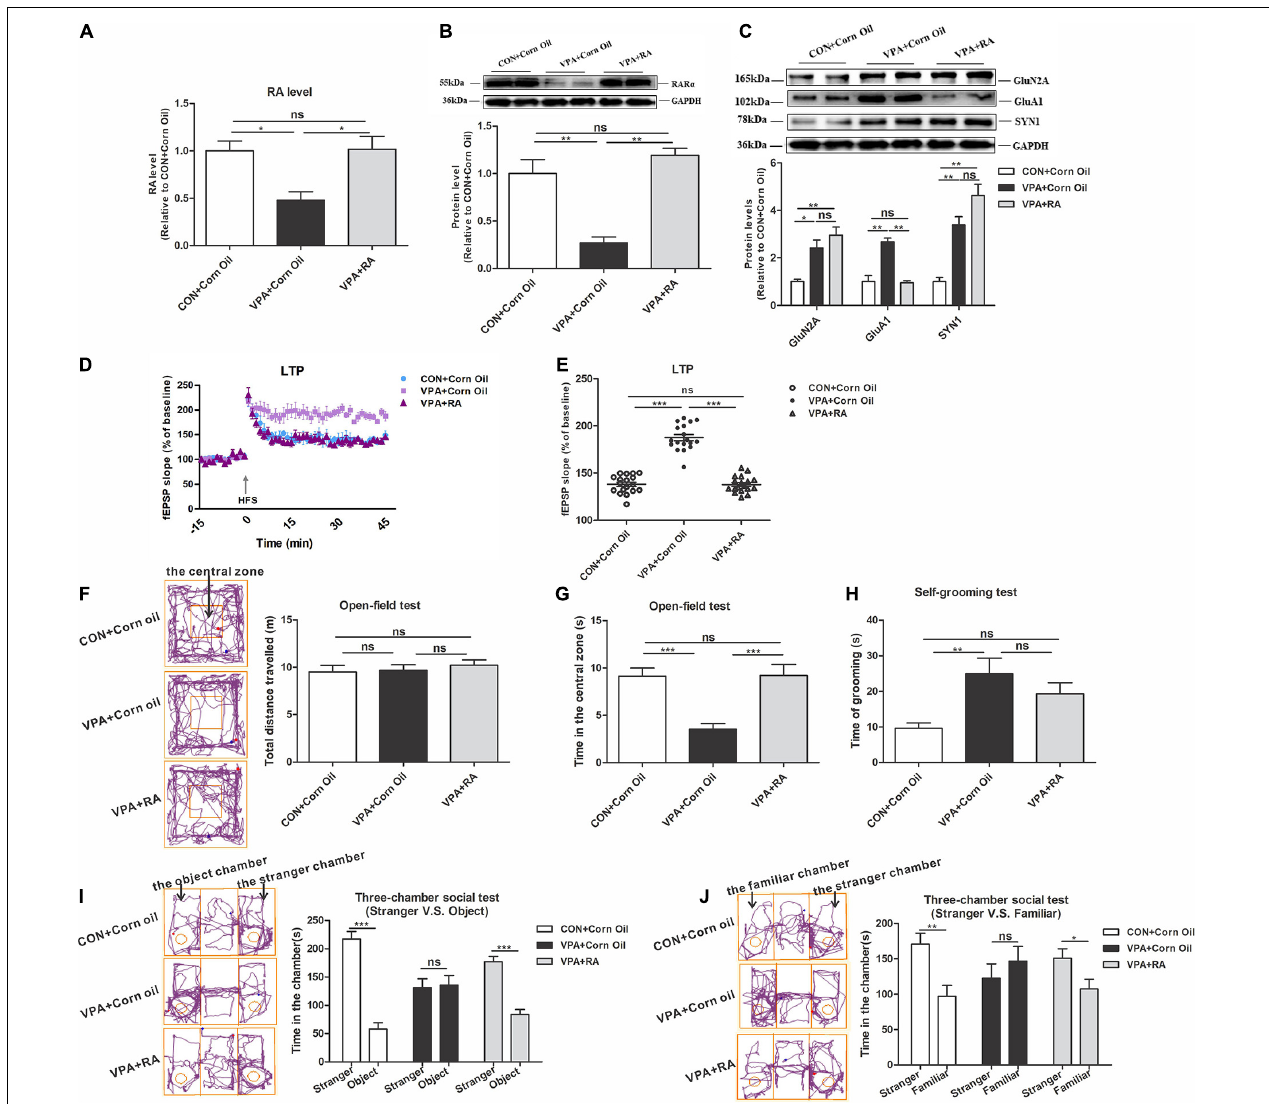
FIGURE 7 | Changes in RAR α expression levels, homeostatic synaptic plasticity and autism-like behaviors in VPA-exposed offspring following RA intervention. (A) RA levels in the PFC from the CON + Corn Oil, VPA + Corn Oil, and VPA + RA groups, as quantitated using UPLC-MS/MS ( n = 5 per group). (B) Western blot and quantification analyses of RAR α protein in the PFC from the CON + Corn Oil, VPA + Corn Oil, and VPA + RA groups ( n = 3 per group). (C) Western blot and quantification analyses of GluN2A, GluA1, and SYN1 protein in the PFC of offspring from the CON + Corn Oil, VPA + Corn Oil, and VPA + RA groups ( n = 3 per group). (D) Summary graphs of PFC LTP in the CON + Corn Oil, VPA + Corn Oil, and VPA + RA groups ( n = 9 slices from four rats per group). (E) LTP magnitude was measured as an average potentiation at 41–45 min after the onset of HFS induction ( n = 9 slices from four rats per group). (F–J) Behavioral tests were performed in offspring from the CON + Corn Oil, VPA + Corn Oil, and VPA + RA groups beginning at PND 43. (F) The tracing and total distance traveled in the open-field test ( n = 20–22 per group, F 2 , 57 = 0.356, P = 0.702). (G) The time spent in the central zone in the open-field test ( n = 20–22 per group, F 2 , 57 = 12.511, P < 0.001). (H) The time spent self-grooming in the open-field test ( n = 20–22 per group, F 2 , 58 = 5.709, P = 0.005). (I) The tracing and social interaction in the three-chamber test (stimulus: a stranger rat vs. an object) ( n = 20–22 per group, t 38 = 9.079, P < 0.001 for CON + Corn Oil group; t 38 = –0.191, P = 0.85 for VPA + Corn Oil group; t 42 = 7.214, P < 0.001 for VPA + RA group). (J) The tracing and recognition of social novelty in the three-chamber test (stimulus: a stranger rat vs. a familiar rat) ( n = 20–22 per group, t 38 = 3.366, P = 0.002 for CON + Corn Oil group; t 38 = –0.836, P = 0.408 for VPA + Corn Oil group; t 40 = 2.243, P = 0.031 for VPA + RA group). Each experiment was repeated at least three times. The values are means ± SEMs. One-way ANOVA with Bonferroni post hoc test (A–H) , Student’s t -test (I,J) , * P < 0.05, ** P < 0.01, *** P < 0.001, ns = not significant; VPA, valproic acid; PFC, prefrontal cortex; RA, retinoic acid; LTP, long-term potentiation; fEPSP, field excitatory postsynaptic potentials; HFS, high frequency train stimulation; PND, postnatal day.